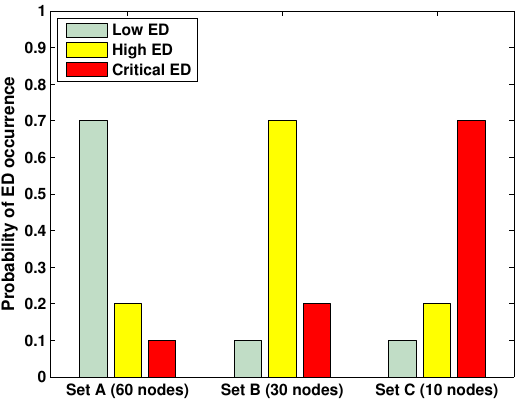
Figure 2. Probability distribution of a node to present a specific emergency